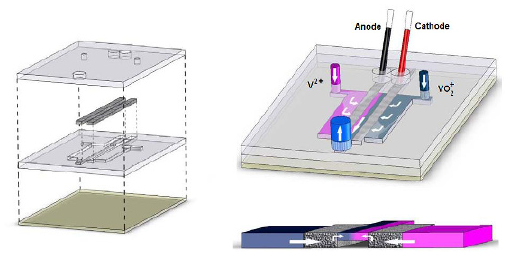
Figure 4. Microfluidic vanadium fuel cell design with flow through porous electrodes [37], Copyright ACS Publications 2008.